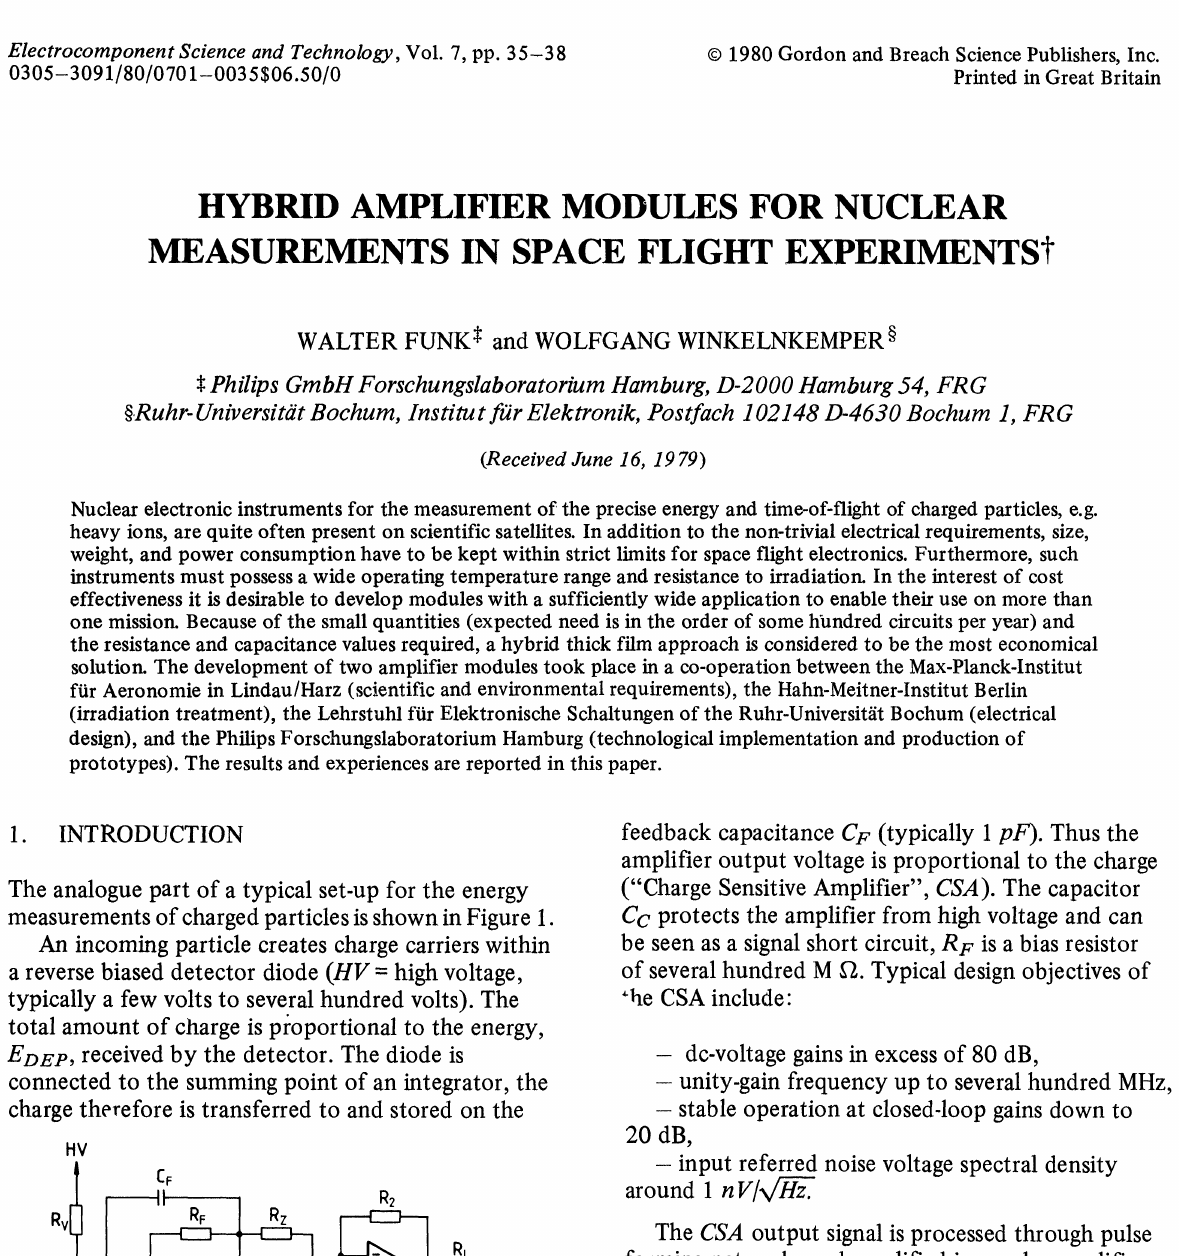
Analog Part of the Energy Measurement